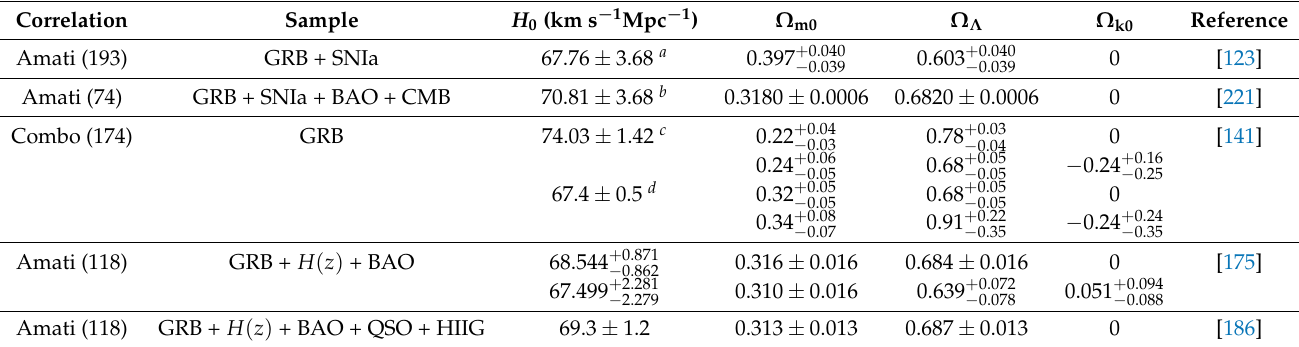
a Inferred from the interpolation of the OHD data by using Bézier polynomials. b Inferred from the interpolation of the OHD data with additional systematic errors [221] by using Bézier polynomials. c Value from Ref. [222]. d Value from Ref.